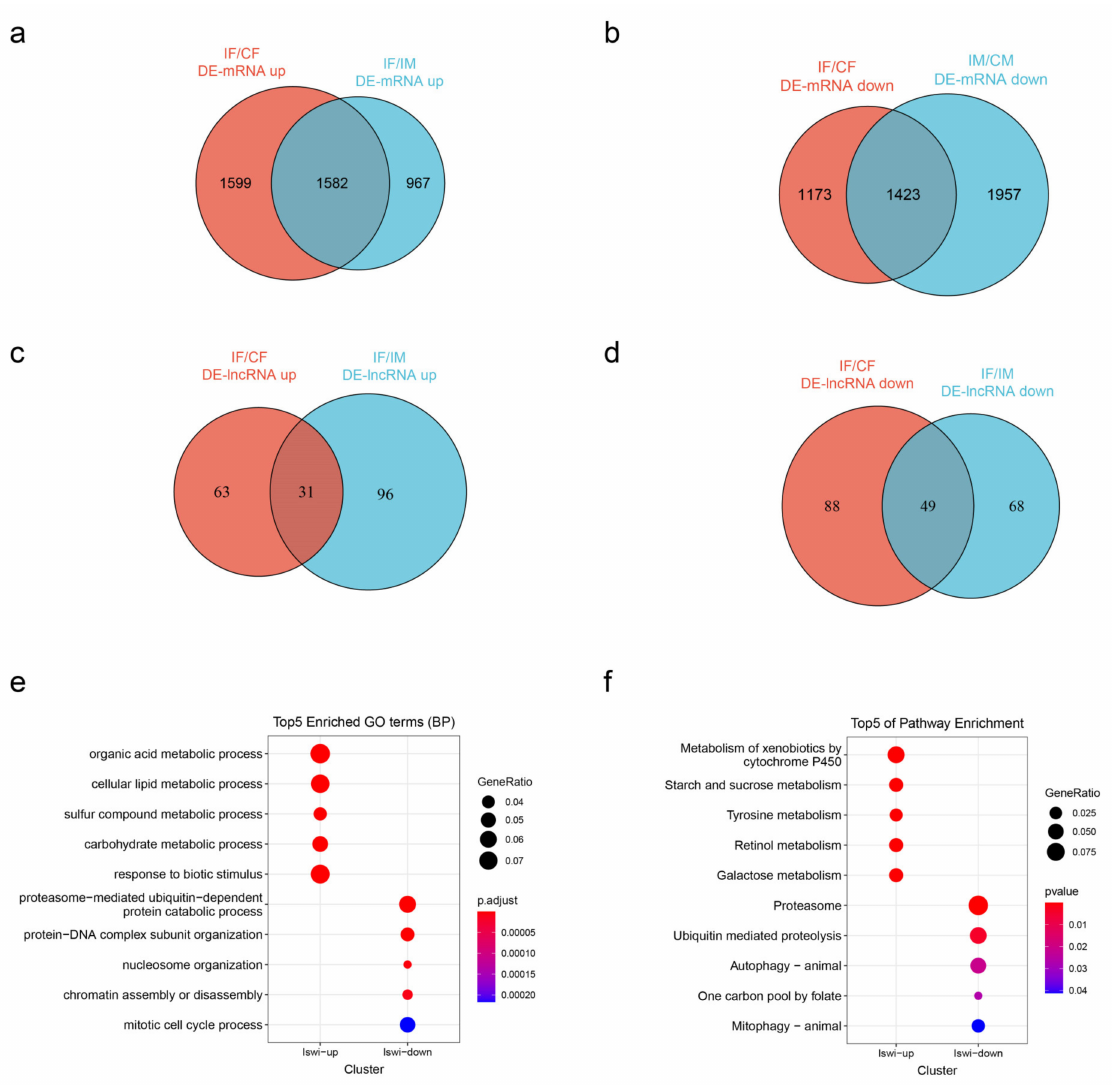
Figure 4. Differentially expressed known mRNAs and lncRNAs. ( a , b ) Venn diagrams show the num- ber of up-regulated ( a ) and down-regulated ( b ) known-mRNAs in ISWI mutants/wild-type Drosophila . ( c , d ) Venn diagrams show the number of up-regulated ( c ) and down-regulated ( d ) known-lncRNAs in ISWI mutants/wild-type Drosophila . ( e ) GO enrichment analysis of differentially expressed known- mRNA. ( f ) KEGG pathway enrichment analysis of differentially expressed